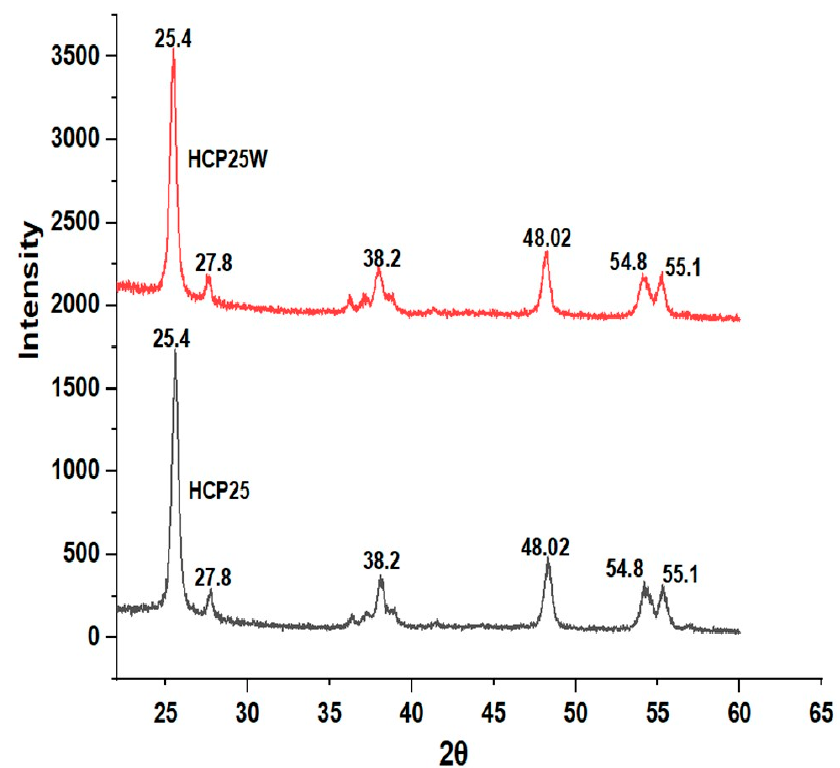
Catalysts 2021 , 11 , x FOR PEER REVIEW Figure 6. XRD diffractograms of HCP25 and HCP25W. Figure 6. XRD diffractograms of HCP25 and HCP25W.